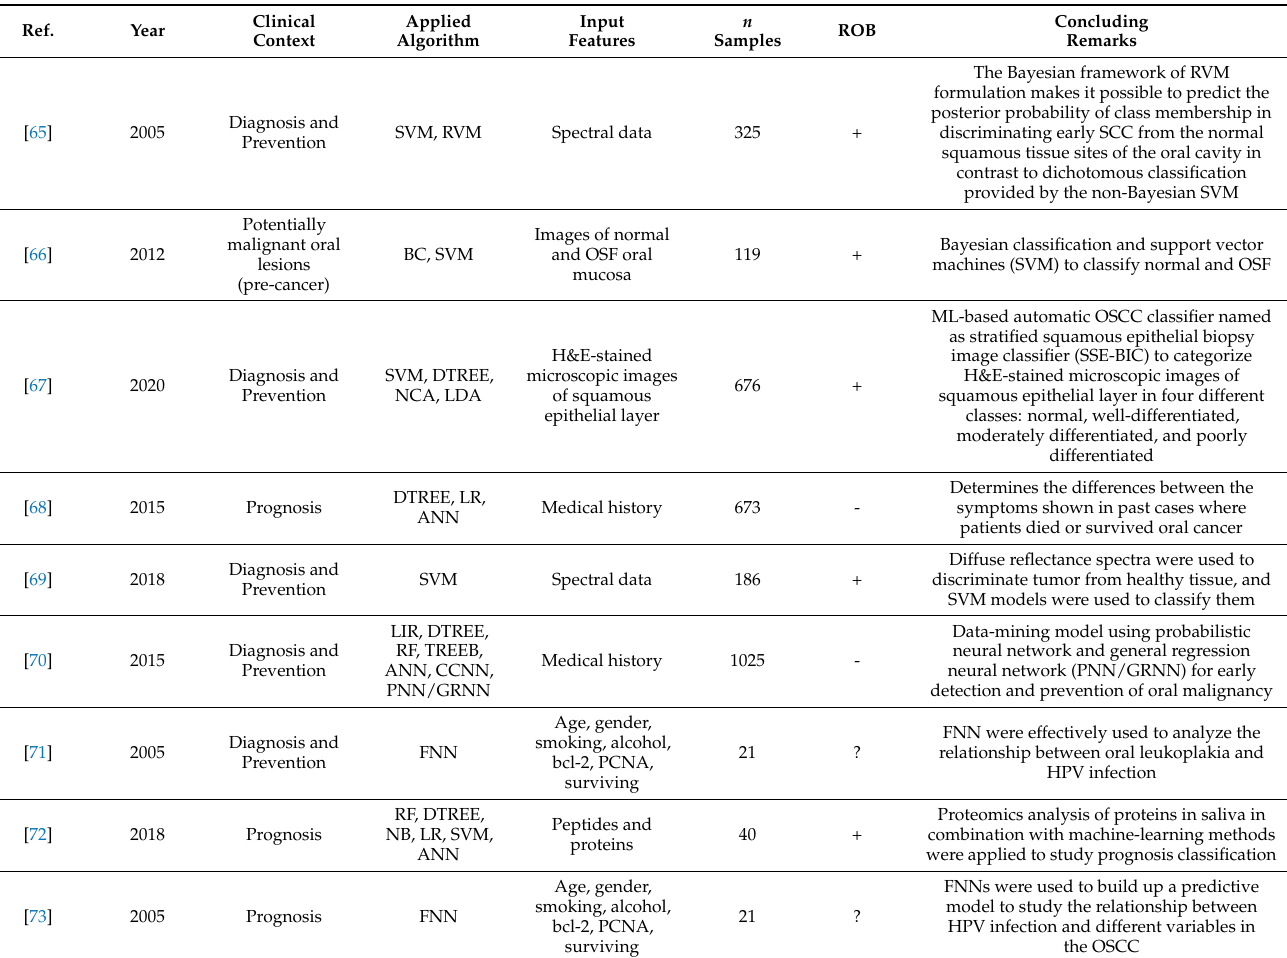
FNNs were used to build up a predictive model to study the relationship between HPV infection and different variables in the OSCC “+” indicates low risk of bias, “-” indicates high risk of bias, and “?” indicates unclear risk of bias, CNN = Convolutional neural network, ANN = Artificial neural network, SVM = Support vector machine, RF = Random forest, DTREE = Decision tree, LR = Regression logistic, BC = Bayesian classifier, ANFIS = Adaptive neuro-fuzzy inference system, WNN = Wavelet neural network, CTREE = Conditional inference trees, BA = Bagging, LDA/QDA = Linear/quadratic discriminant analysis, RVM = Relevance vector machine, MLC = Mahalanobis classifier, LIR = Linear regression, TREEB = Tree boost, CCNN = Cascade correlation neural network, GB = Gradient boosting, NCA = Neighborhood component analysis, DJU = Decision jungle, CTA = Classification tree analysis, PLS-DA = Partial least square discriminant analysis, OPLS-DA = Orthogonal partial least square discriminant analysis, DFG = Data fusion graph, RFC = Randomizable filtered classifier, RT = Random tree, PCA = Principal component analysis, PLS = Partial least squares, NB = Naïve Bayes, KNN = K nearest neighbors, GP = Genetic programing, RT = Random tree, KLLC = Karhunen–Loeve linear classifier, XGBOOST = Extreme gradient boosting, PNN/GRNN = Probabilistic neural network /general regression neural network, FNN = Fuzzy neural network, KSTAR = Instance-based learner using an entropic distance measure, ROB = Risk of bias. In concordance with the four application areas found, the diagnosis and prevention